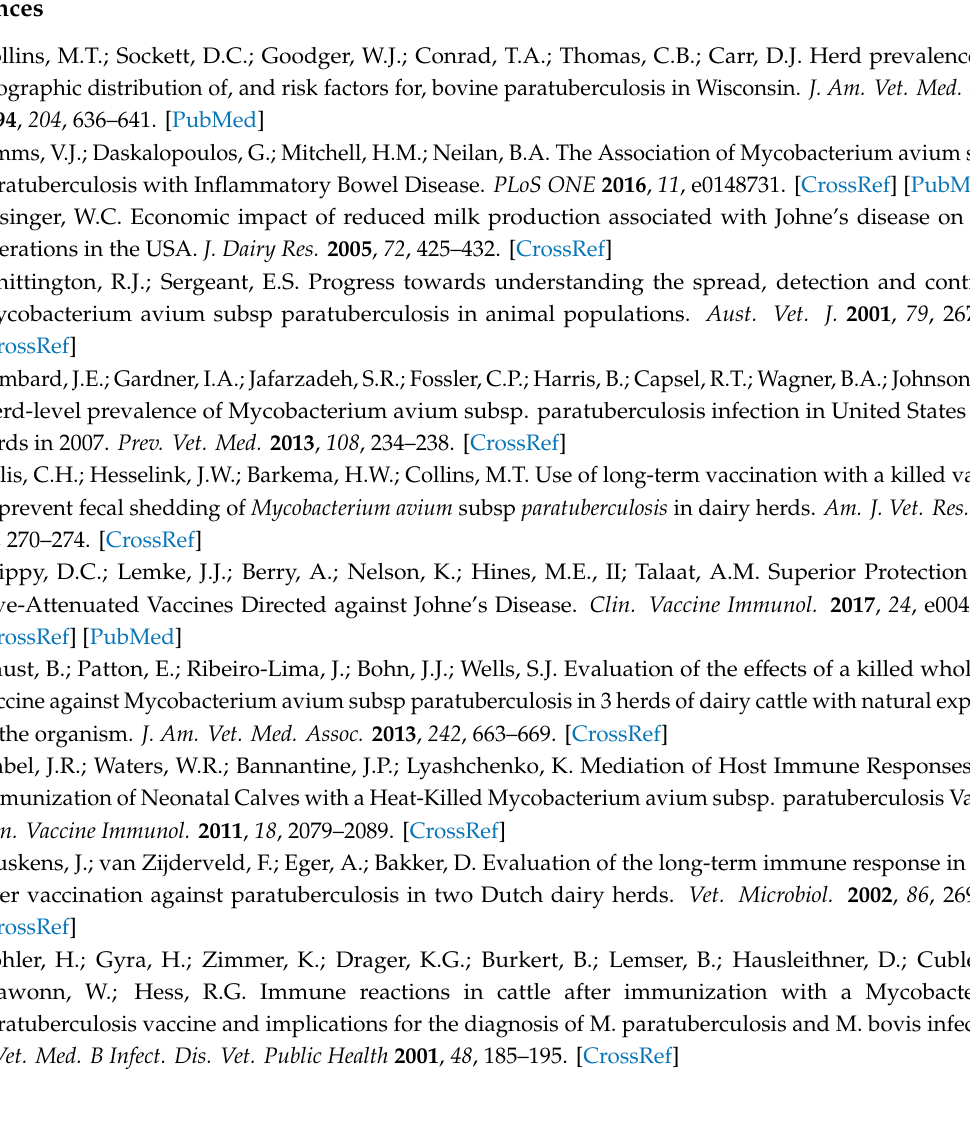
Figure S1: Experimental timeline for vaccination and challenge, Figure S2: Body temperature following vaccination, Figure S3: Body weights following challenge. Table S1: Vaccine shedding in saliva and fecal samples detected